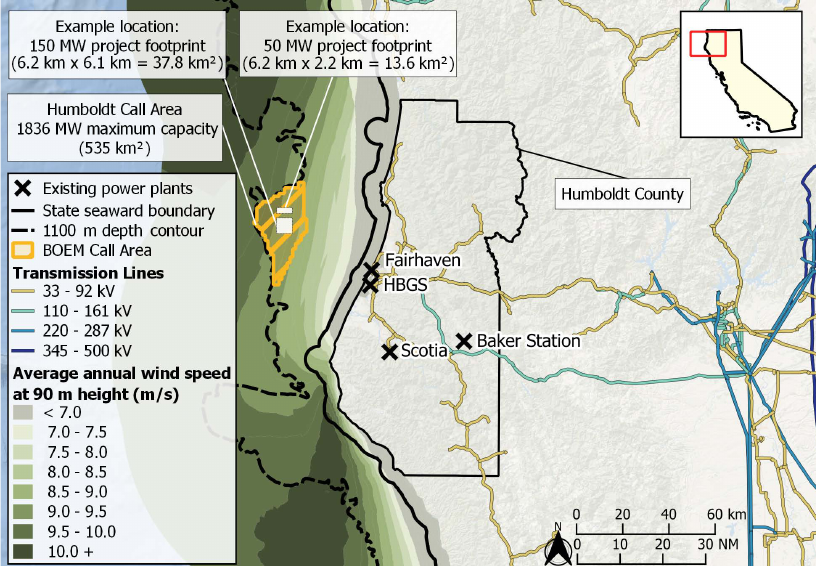
Figure 3. Average o ff shore wind speeds and extant transmission connections to Humboldt